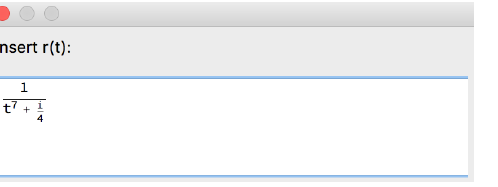
Figure 51. Part of the structure of the [ASPPlusPMinus] algorithm corresponding to Option 1 to input r .